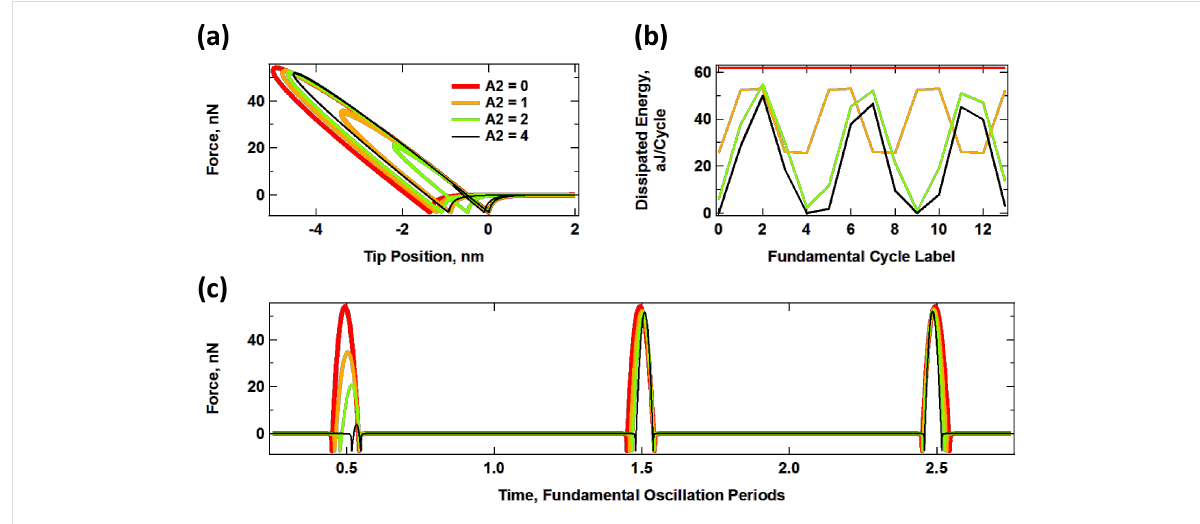
Figure 5: Interaction of an SLS surface with a probe oscillating along a bimodal trajectory of constant maximum penetration, given by z tip ( t ) = (95 nm + A 2 ) + (100 nm)·cos( ω 1 t ) + A 2 cos(6.21· ω 1 t ), with ω 1 = 2 π (50 kHz), K inf = K o = 7.5 N/m and C diss = 1 × 10 − 5 N·s/m. (a) Force–distance trajectories for varying A